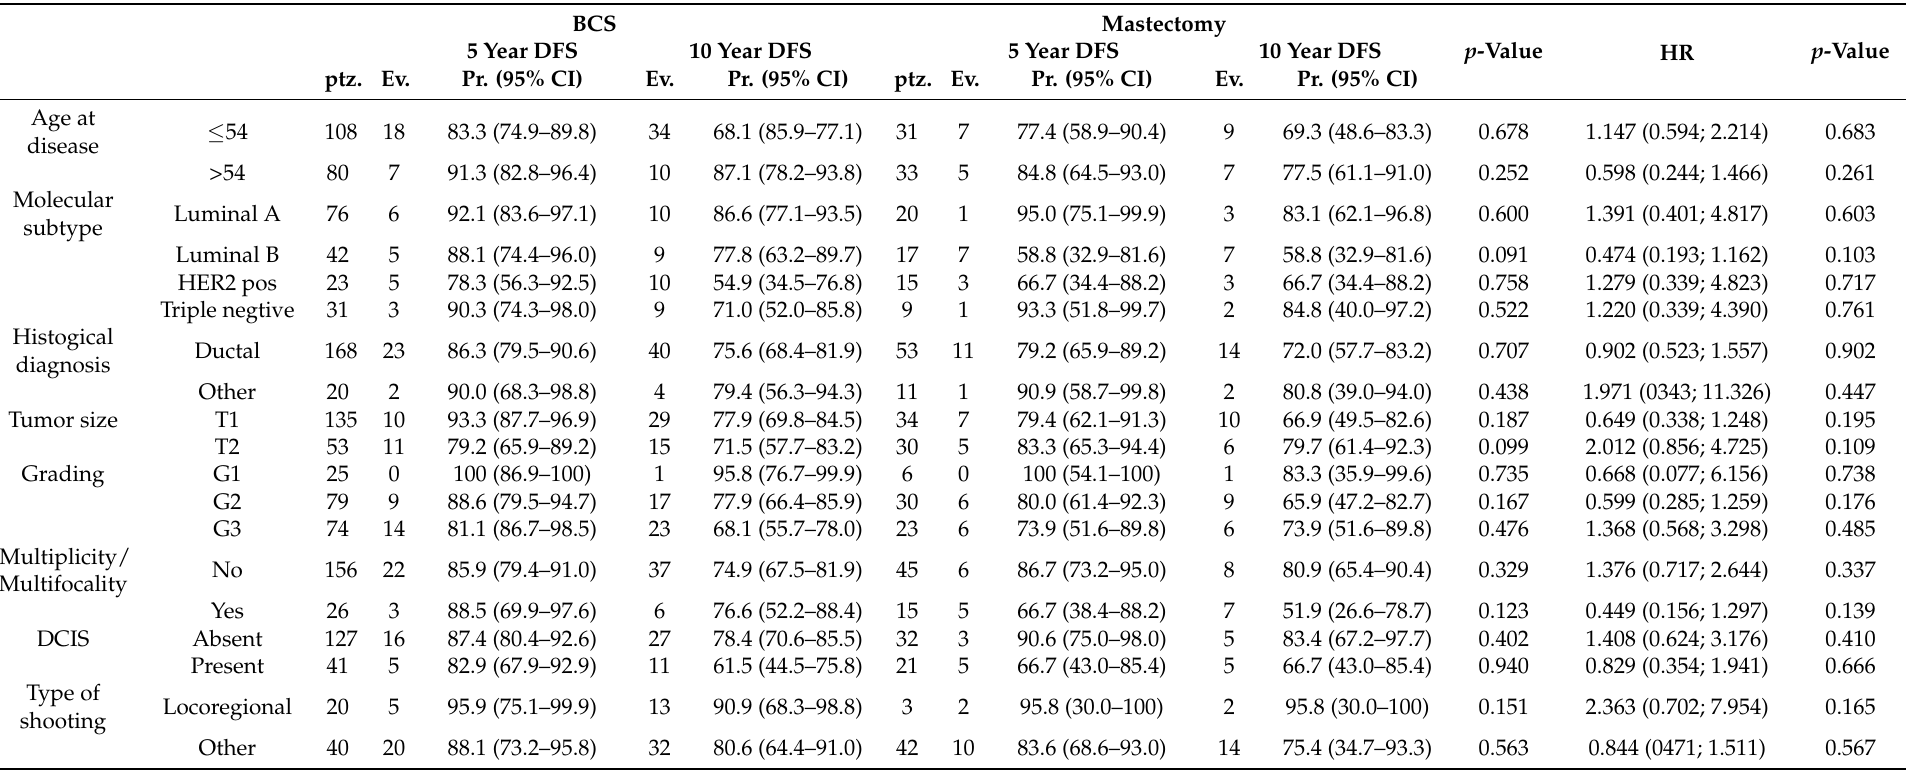
Table 2. DFS and HR of patients treated with BCS and mastectomy with respect to age and histological characteristics. p -value refers to the DFS curve for the sub-sample considerated. HR was calculated for each of the subcategories of patients with respect to the type of intervention received, considering BCS the reference category. ptz.: patients; Ev.: events; Pr.: